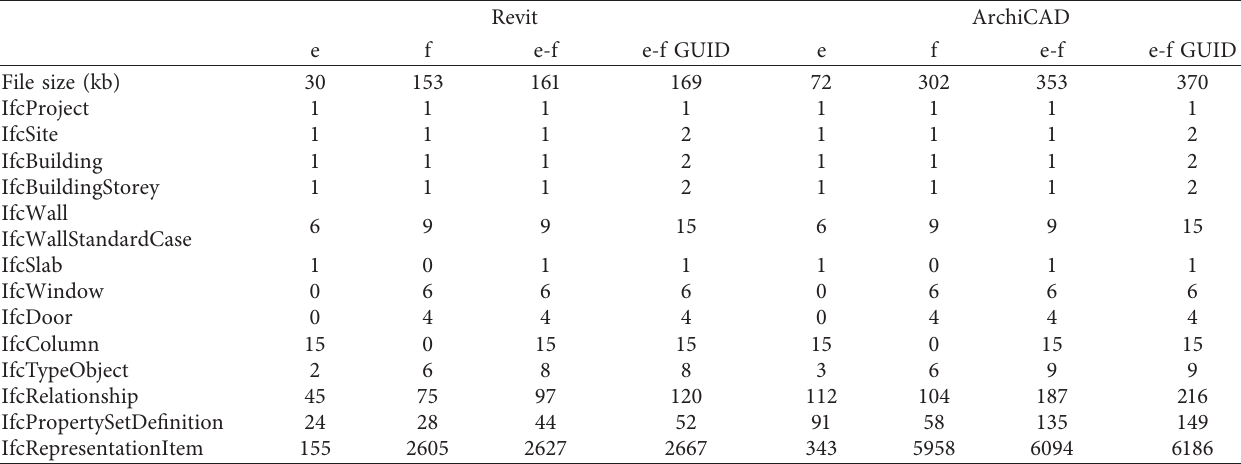
Table 3: Entity statistics for scenarios e and f.